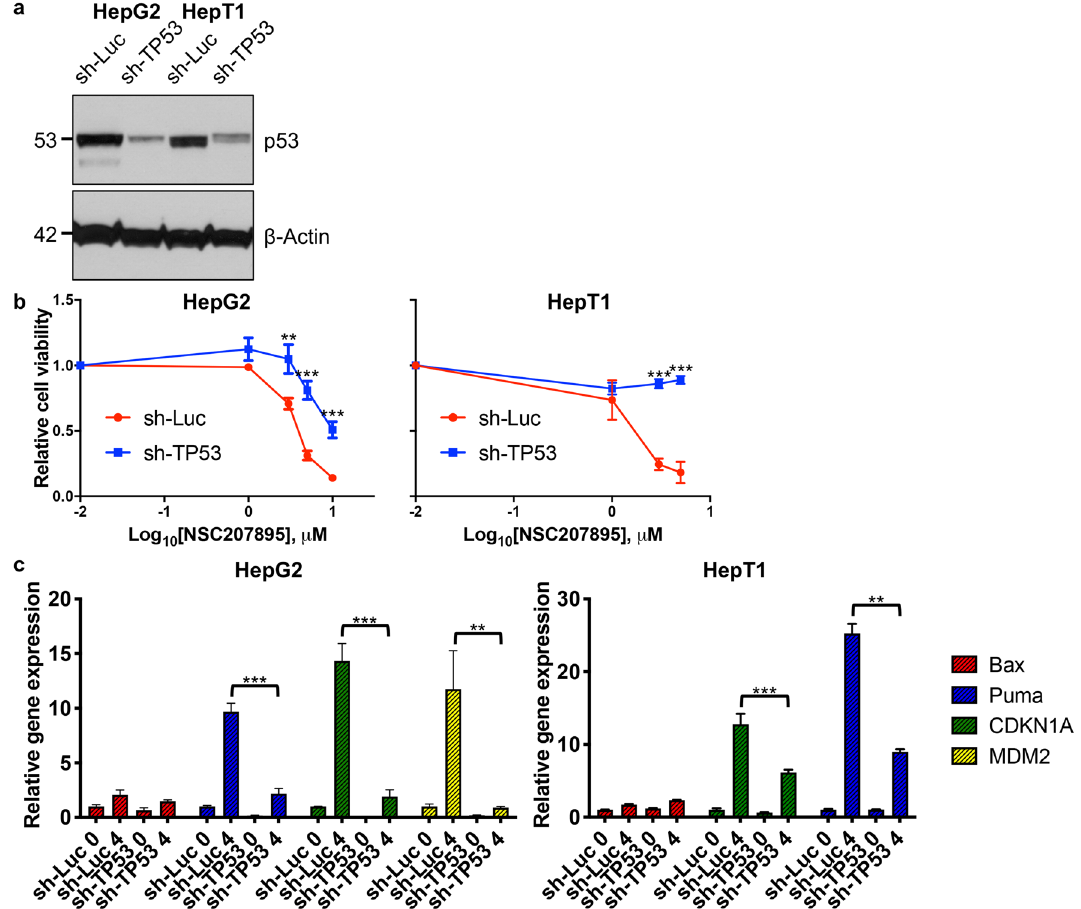
Figure 6. Cytotoxic effects of NSC207895 are dependent on p53 signaling. ( a ) Immunoblotting with HepG2 and HepT1 cells transduced with sh-TP53 or control sh-Luc with an antibody recognizing p53. β-Actin immunoblotting was used as a loading control. Data shown are representative of at least three independent experiments. Full length blots for data shown in a are presented in Supplementary Fig. 10. ( b ) Cells transduced with sh-TP53 or control sh-Luc were incubated with varying indicated concentrations of NSC207895 for 48 h. MTT assays were performed at 48 h to assess viability. ( c ) Bar graphs representing normalized mRNA expression of p53 targets Bax , Puma , CDKN1A , and MDM2 analyzed with qPCR experiments. RNA was extracted from cells transduced with sh-TP53 or control sh-Luc treated with 10 μM NSC207895 for 0 or 4 h. Expression in treated cells (4 h) was compared to that from untreated cells (0 h). Data shown in b and c are representative of at least three independent experiments performed with three replicate wells each time. Error bars represent SD. Student’s t test (two tailed) * P < 0.05, ** P < 0.01, *** P <